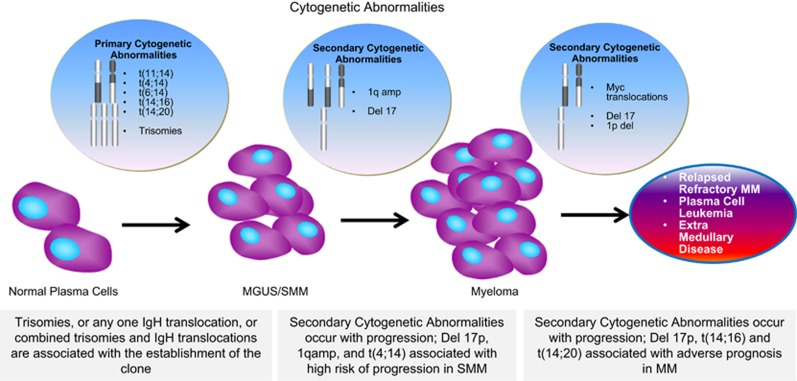
Cytogenetic abnormalities in multiple myeloma. Primary cytogenetic abnormalities occur early when the normal plasma cell transitions to a clonal, premalignant stage. Most secondary cytogenetic abnormalities occur later in the disease course with malignant transformation or during progression of the malignancy. The effect of primary and secondary cytogenetic abnormalities on prognosis depends on the disease.